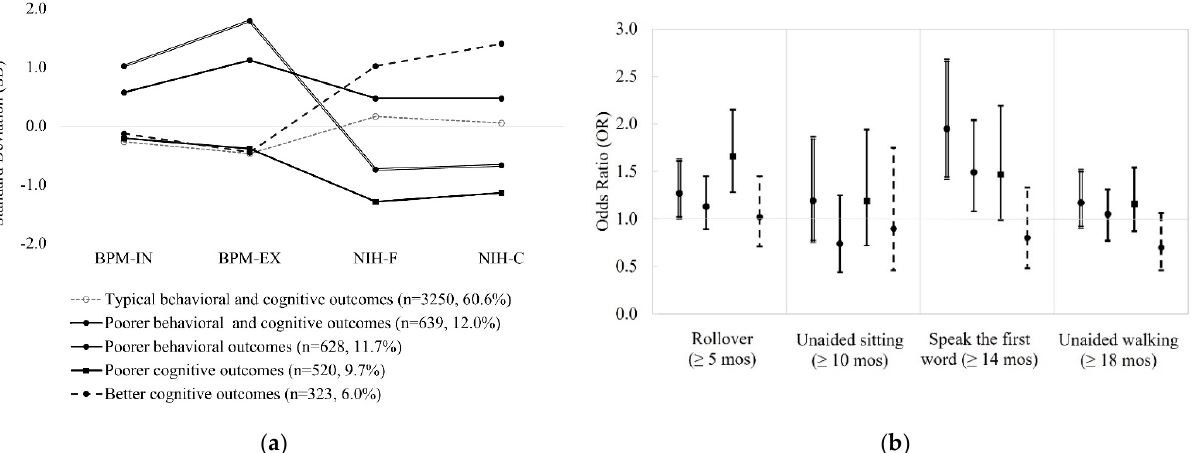
Figure 2. Estimated association between delays in infancy milestone attainment and LPA-identified profiles of childhood neurodevelopment outcomes at age 9–10, adjusted for maternal sociodemo- graphic characteristics (age at delivery, race/ethnicity, marriage status, education level, residential average of family income, self-reported mental health problems) and child’s sex at birth. ( a ). Latent profiles of childhood neurodevelopment (fluid/crystallized cognition, internalizing/externalizing behaviors) at age 9–10; ( b ). The odds ratio (OR) and 95% confidence interval (CI) for latent profiles of childhood neurodevelopment at age 9–10 according to delays in infancy milestone attainment.